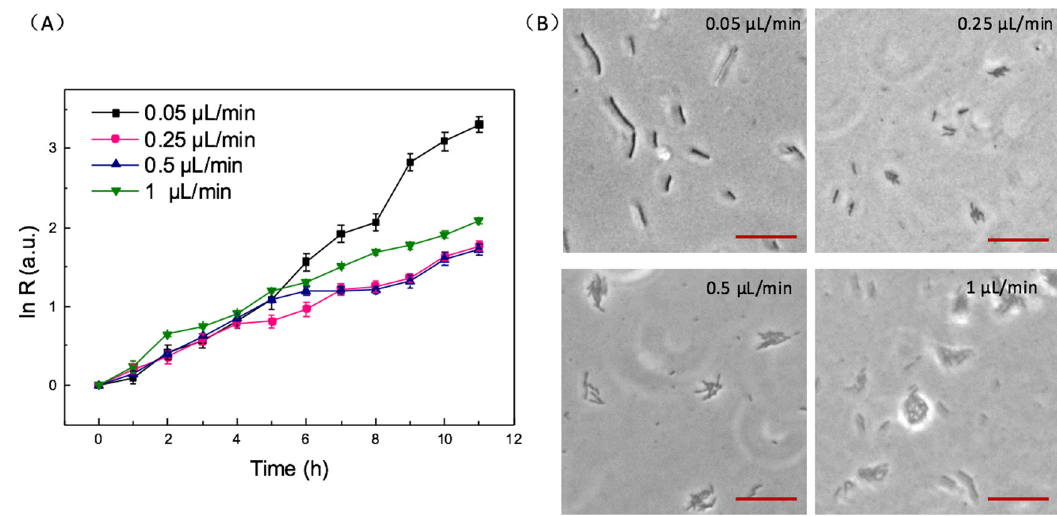
Figure 4. Growing situations at continuous flow of different velocities. ( A ) bacterial growth rate during incubation at velocity of 0.05 μ L/min, 0.25 μ L/min, 0.5 μ L/min, 1 μ L/min. ( B ) The photomicrographs of bacteria culture on chip for 10 h at velocity of 0.05 μ L/min, 0.25 μ L/min, 0.5 μ L/min, 1 μ L/min. The scale bar is 5 μ m. Error bars are standard deviations.